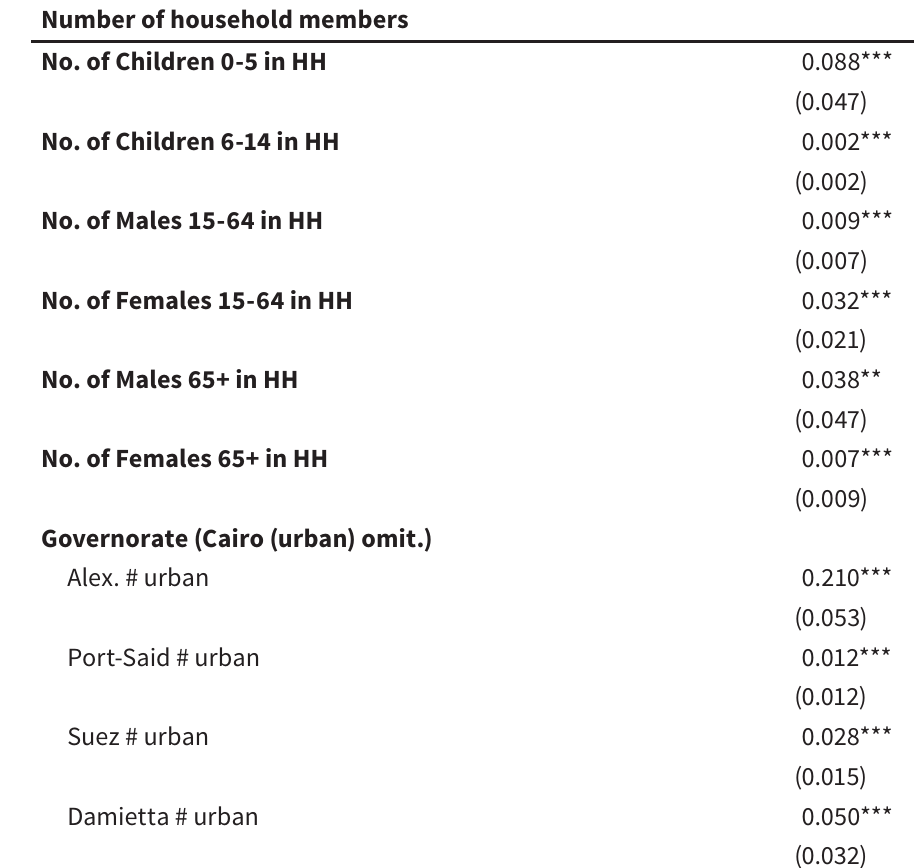
Type II attrition logit model: odds ratios for probability of attrition Number of household